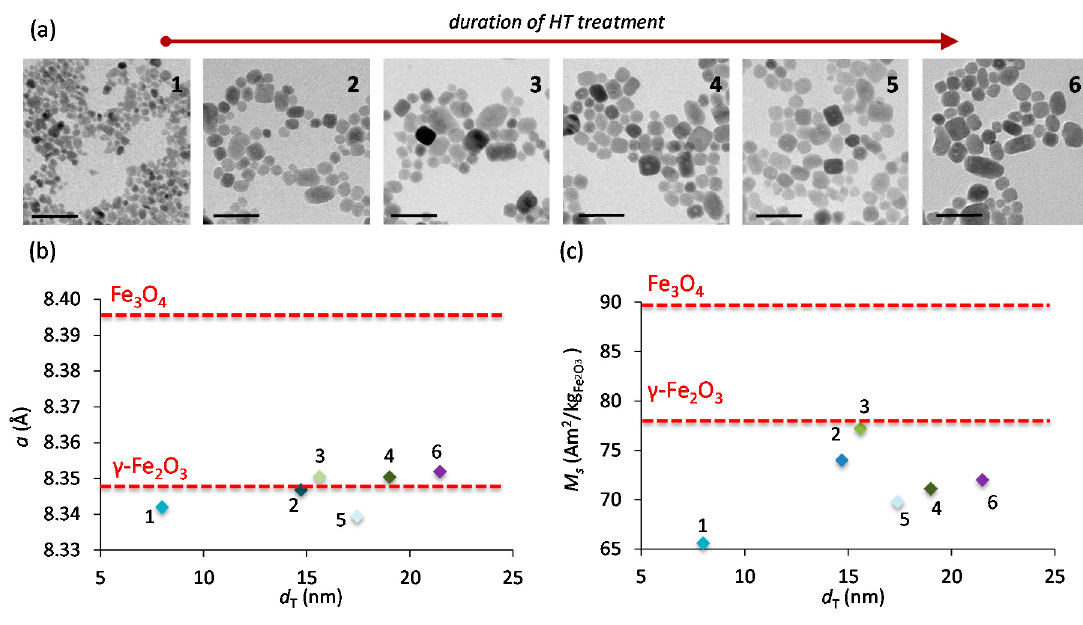
Figure 1. ( a ) Representative TEM micrographs of IONP samples. The scale bars on the micrographs are 50 nm. The red arrow on the top indicates the direction of the increase of the duration of the HT treatment. ( b ) Lattice parameter, and ( c ) saturation magnetization measured at 300 K for IONPs compared with corresponding values of stoichiometric maghemite ( γ -Fe 2 O 3 ) and magnetite (Fe 3 O 4 ) used as reference and marked by red lines.